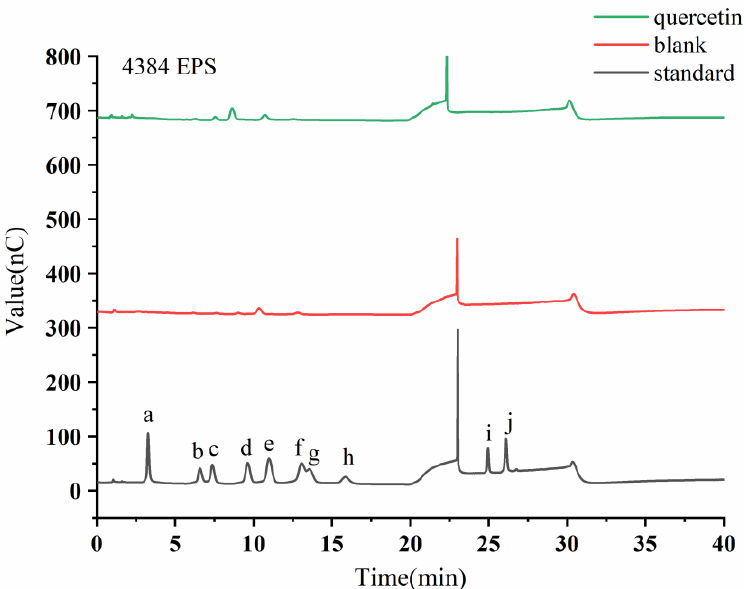
Figure 5. HPAEC-PAD chromatogram profiles of extracellular Monascus exopolysaccharides after adding flavonoids. The letters a-j denote the monosaccharide standards of Fuc, Rha, Ara, Gal, Glc, Xyl, Man, Fru, GalA, and GlcA, respectively.